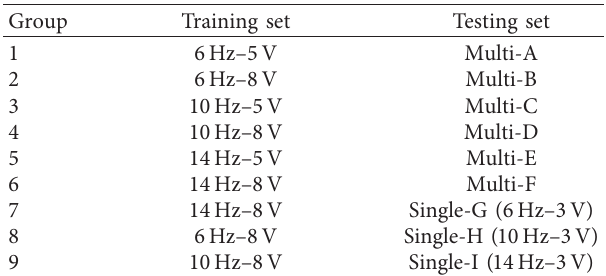
Table 4: Data sets